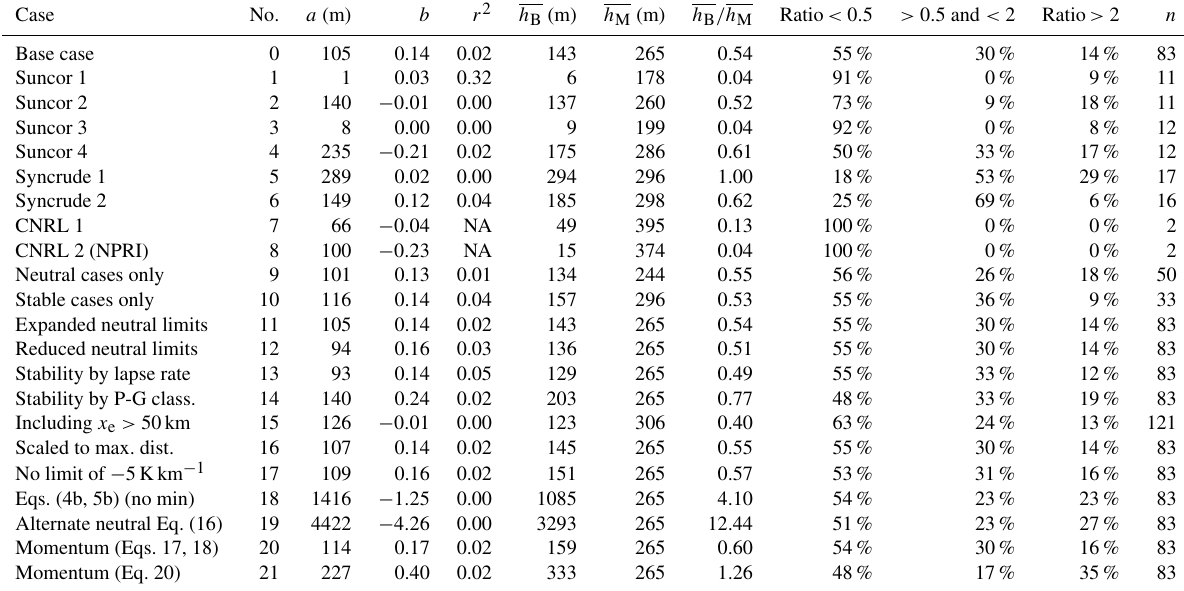
Table 6. Statistics comparing the predicted to measured plume rises using the Briggs parameterization (Eqs. 1–6) with either select conditions only or modification to the analysis. Cases are described in further detail in the text. Variables are defined as in Table 3. The listings of NA indicate the the correlation coefficient is not applicable for a fit with two data